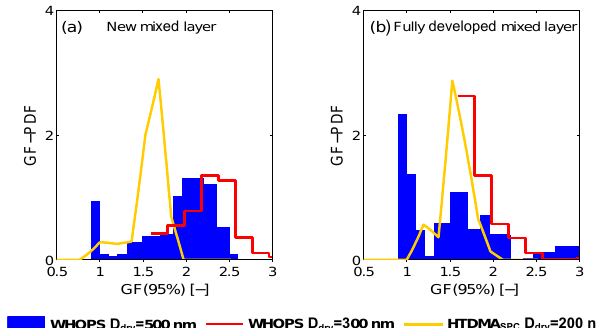
Figure 5. GF-PDF comparison between WHOPS (at 100ma . g . l . ) and HTDMA in the Po Valley on 20 June 2012. The WHOPS results were averaged from 08:30–10:00LT for the new ML and 12:30– 14:00LT for the fully developed ML, equivalent to results in Fig. 3a and b. The HTDMA data were averaged over the same time interval which corresponds to the mean over three full measurements per layer. Note that the WHOPS cannot reliably detect particles with GF < 1.5 and D dry = 300nm, as described in Rosati et al. (2015). Thus, no information is available from the WHOPS measurements on the number fraction and properties of the 300nm particles with GF <